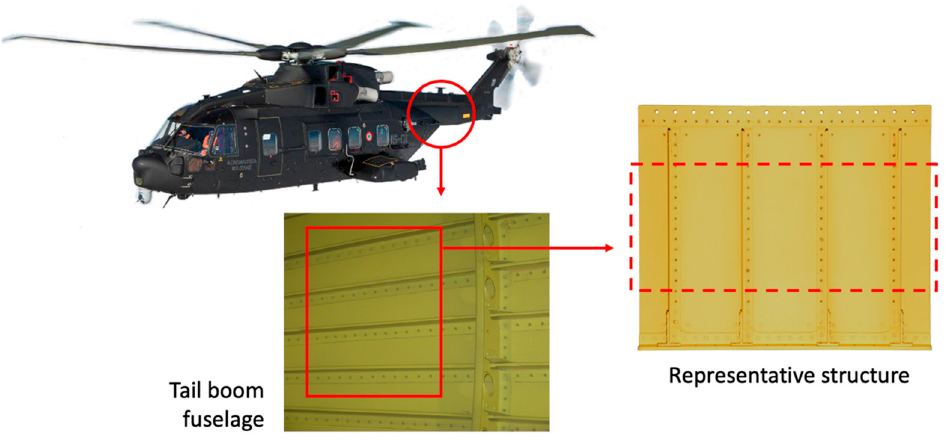
Figure 4. Helicopter with representative